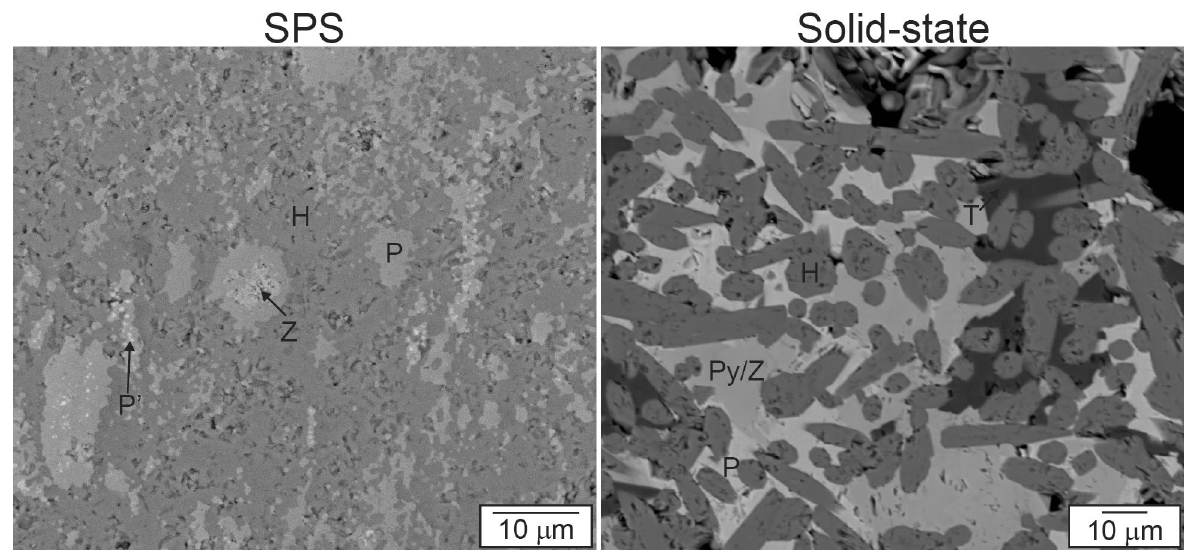
Figure 3. Microstructures of SPS and solid-state sintered surrogate ceramic waste forms, H—hollandite, P and P’—perovskite, zirconium-rich—Z, TiO